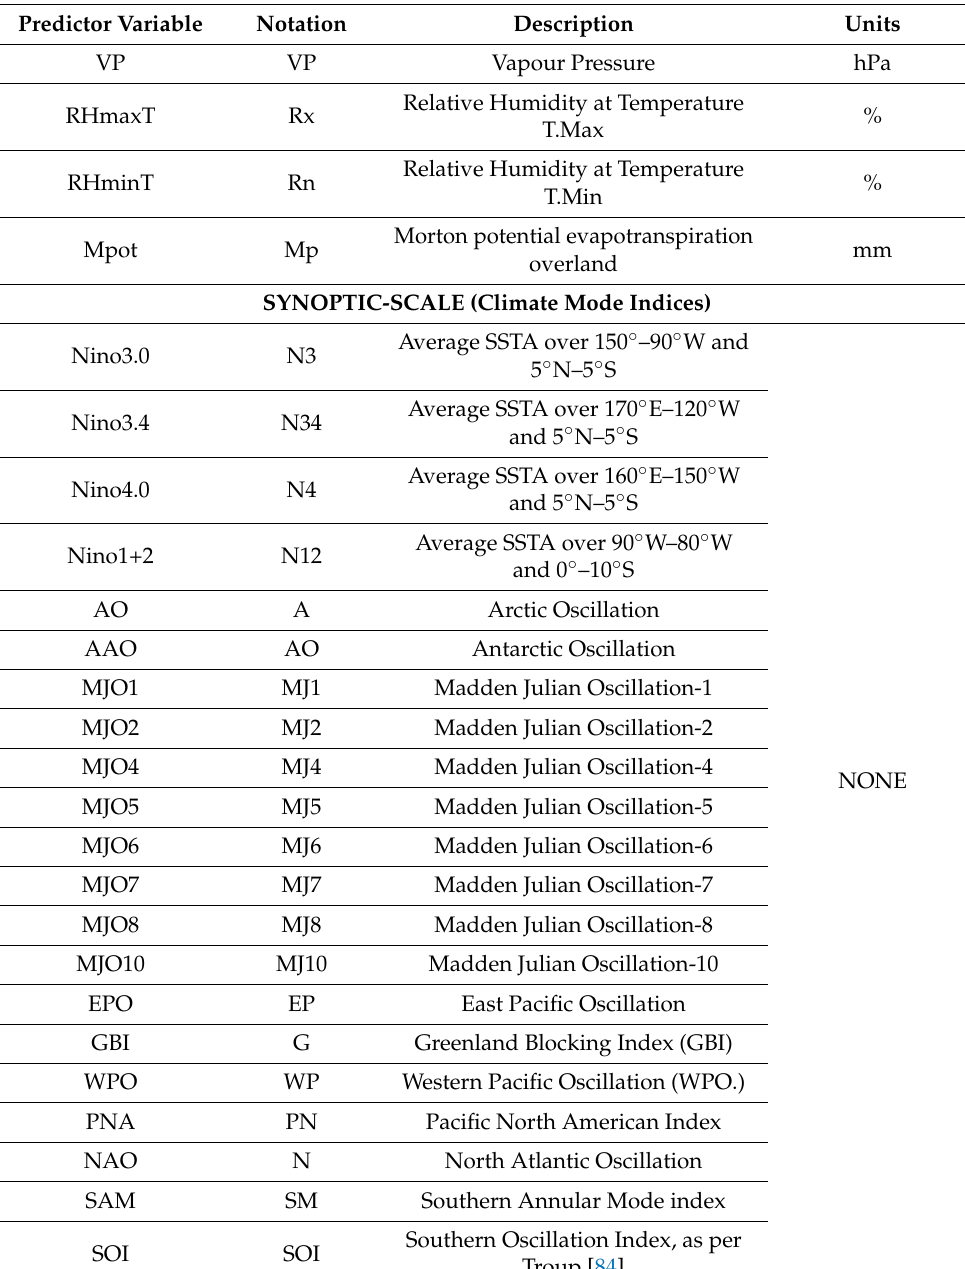
Table 2. Cont. GLDAS 2.0: Modis Satellite Data from Giovanni